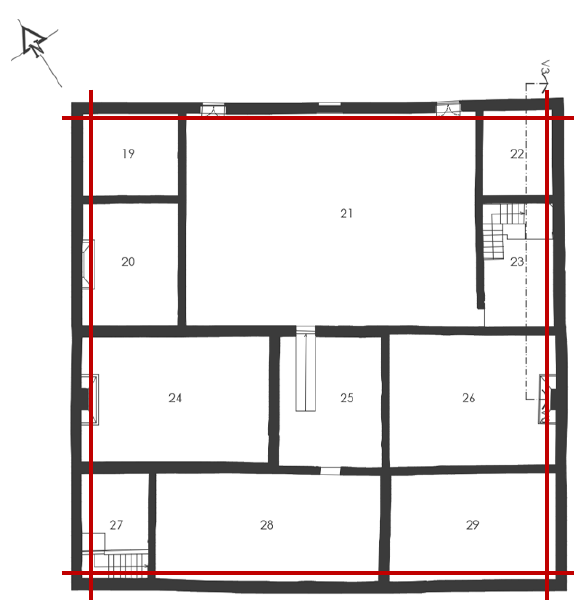
Figure 8: First floor plan H2, out-of-plane deformation of the masonry walls (Municipality of Mantua).